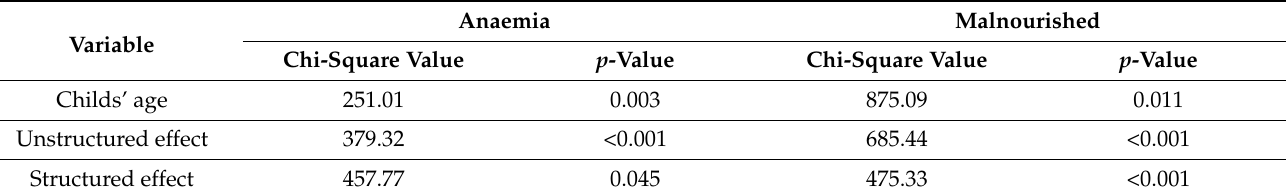
Table 6. Approximate significance for the spatial and non-linear effects.